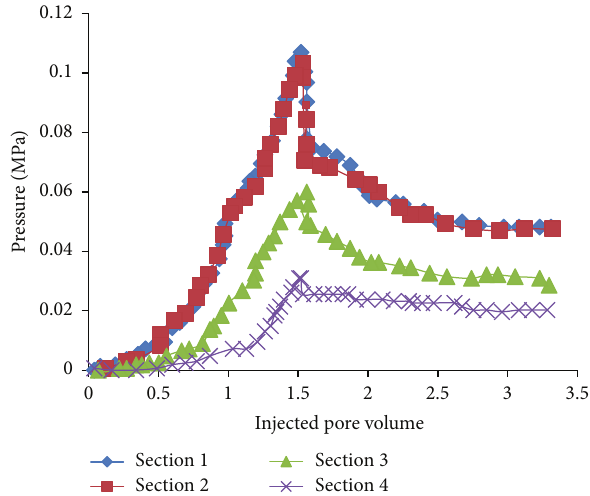
Figure 13: The plot of the injection pressure (diameter: 0.02– 0.06 mm, concentration: 3000